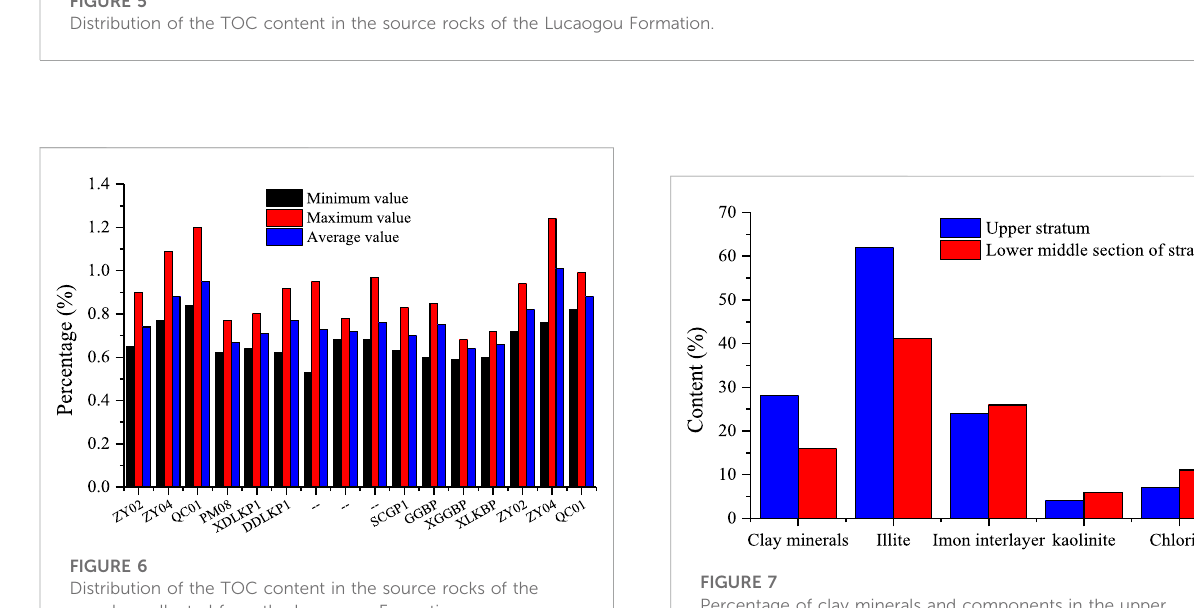
FIGURE 6 Distribution of the TOC content in the source rocks of the samples collected from the Lucaogou Formation.